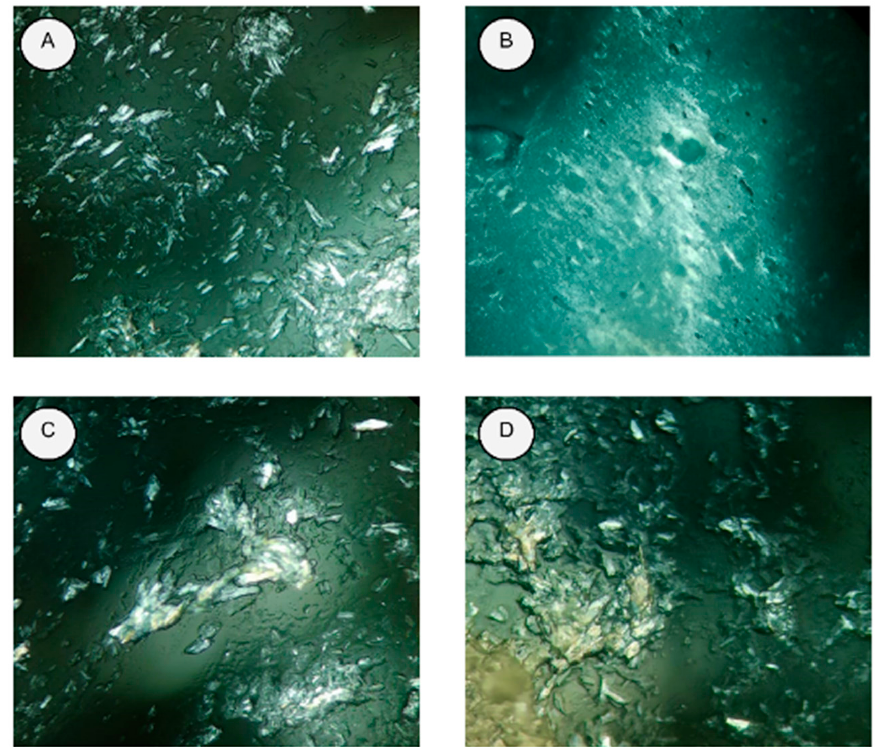
Figure 2. Images obtained with the technique of polarized light microscopy with 40 × magnification of the butters: ( A ) murumuru; ( B ) babassu; ( C ) bacuri; ( D ) ucuuba.